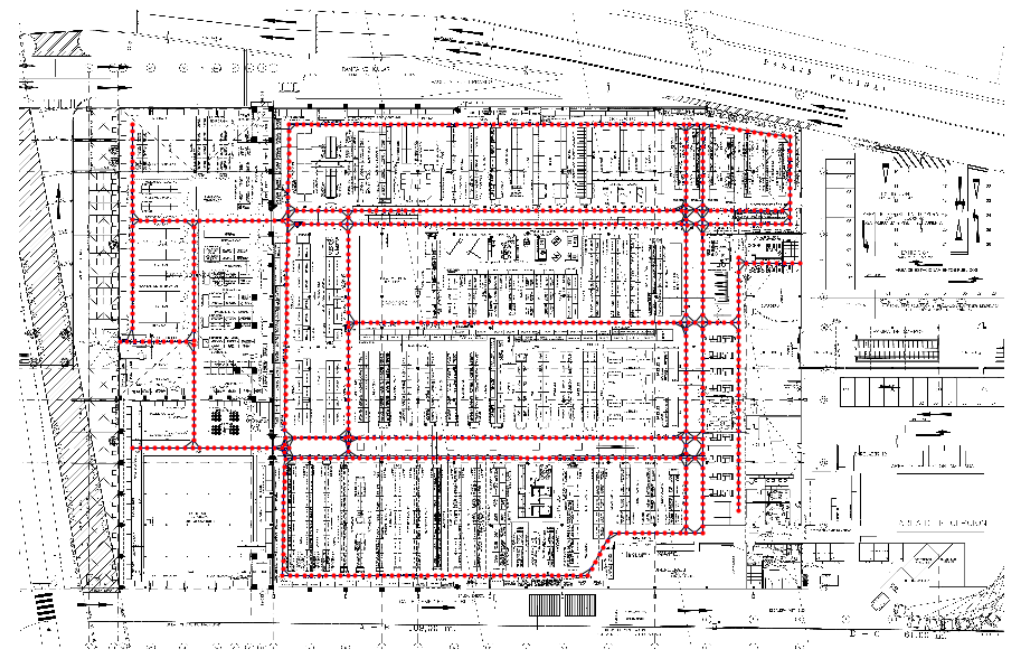
Figure 1. Sample graph on a hardware store